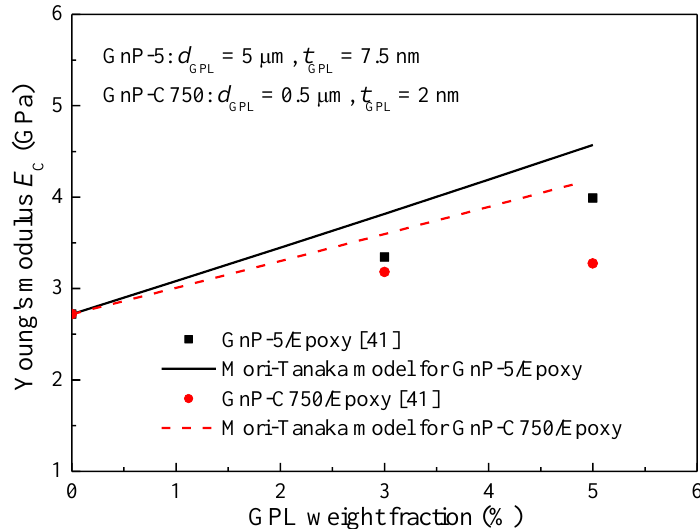
Figure 5. Comparison between present results and experimental data.